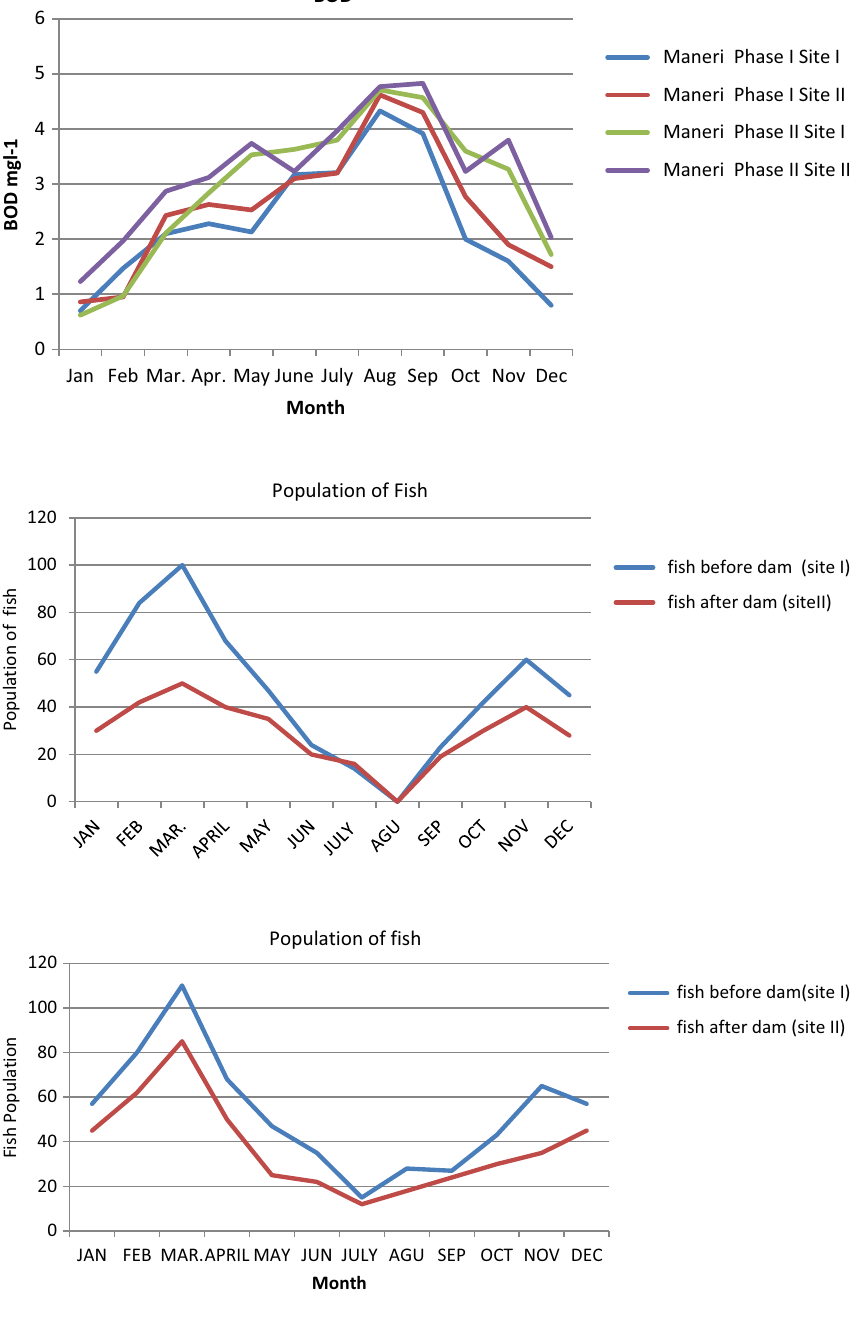
Fig. 14 Monthly variation in the fish population of Bhagrathi river at site I & site II of